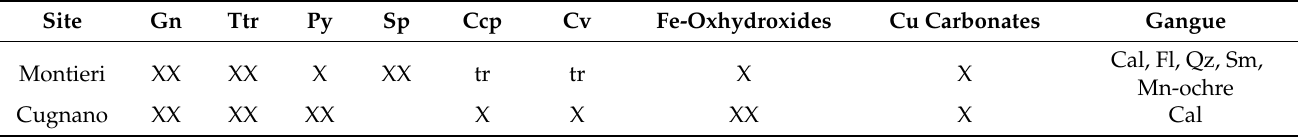
Table 1. Main ore mineralogy of investigated sites. Abbreviations: Gn—galena; Ttr—tetrahedrite; Py– pyrite; Sp—sphalerite; Ccp—chalcopyrite; Cv—covellite; Cal—calcite; Fl—fluorite; Qz– quartz; Sm—smithsonite; tr = trace; x = present; xx =